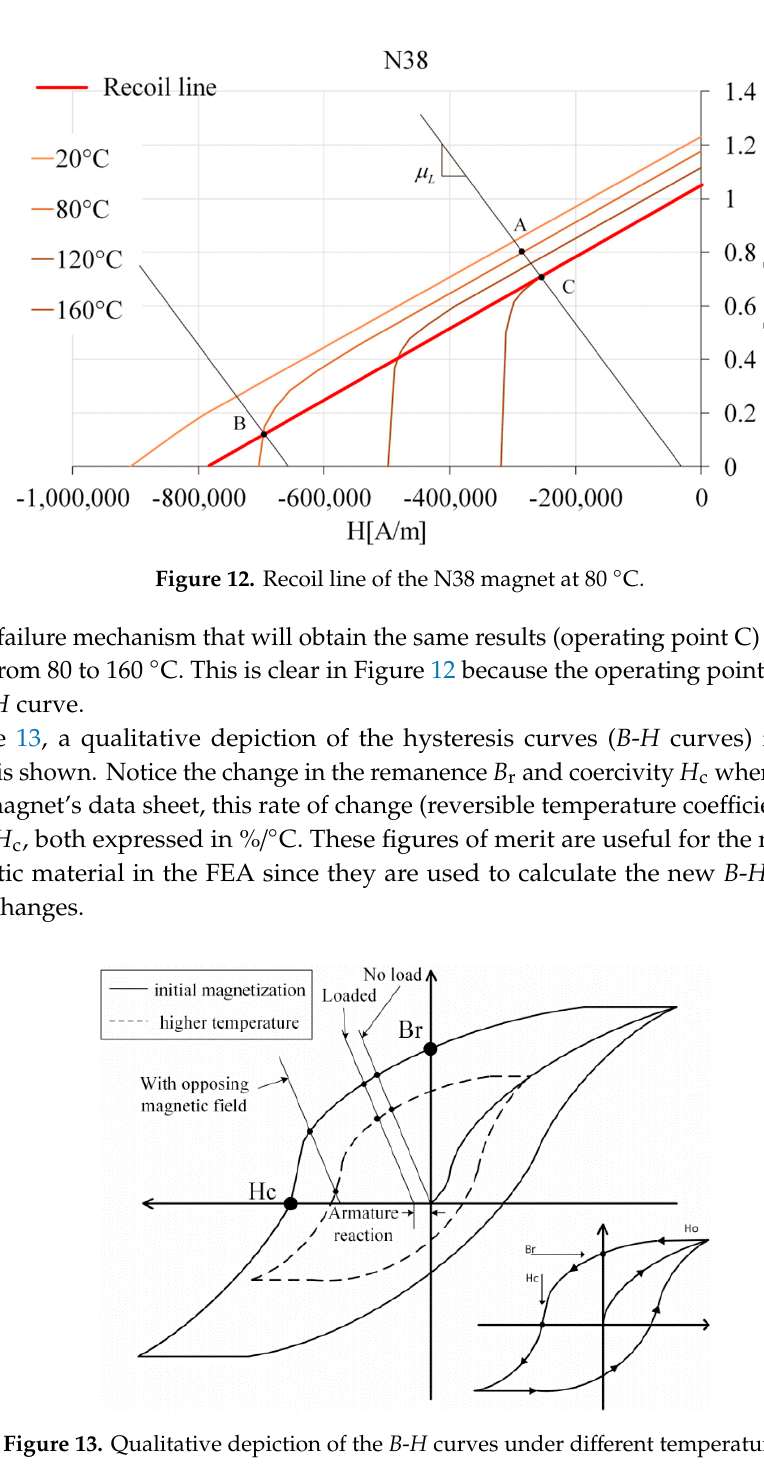
Figure 13. Qualitative depiction of the B - H curves under different temperatures.